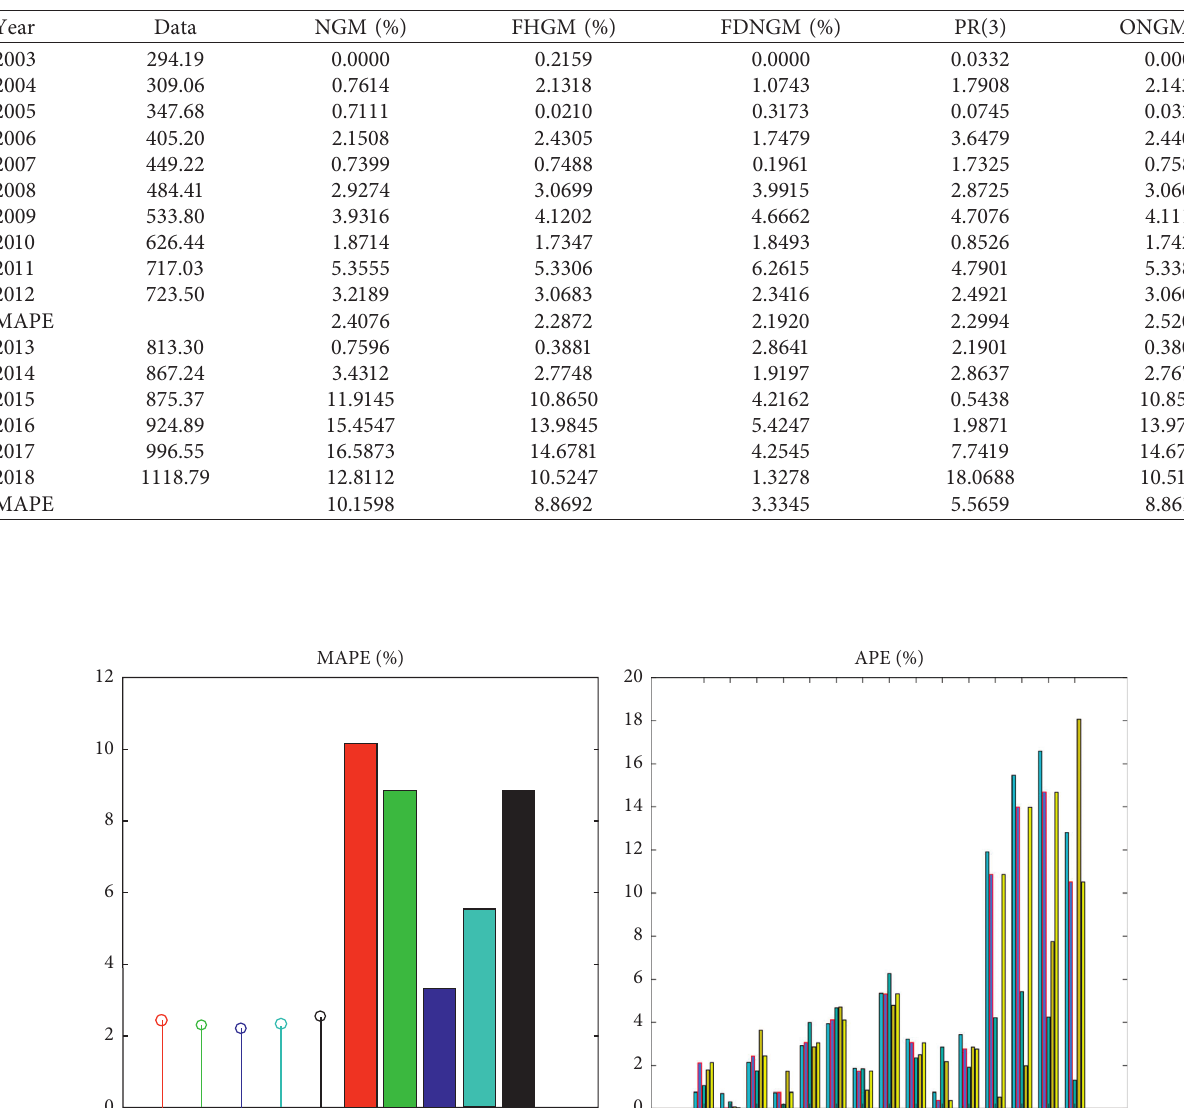
Table 3: The error-value indices of the competing models in Case 1.